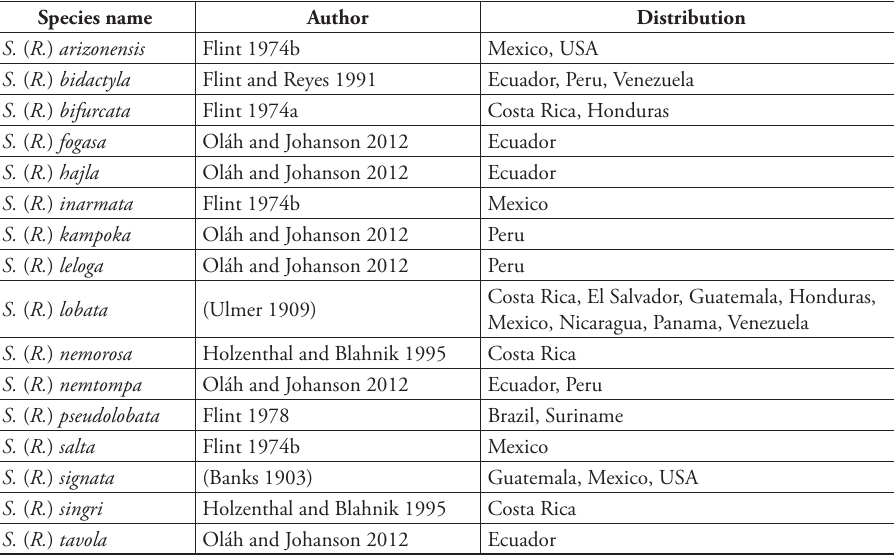
Table 1. Smicridea ( R. ) signata species